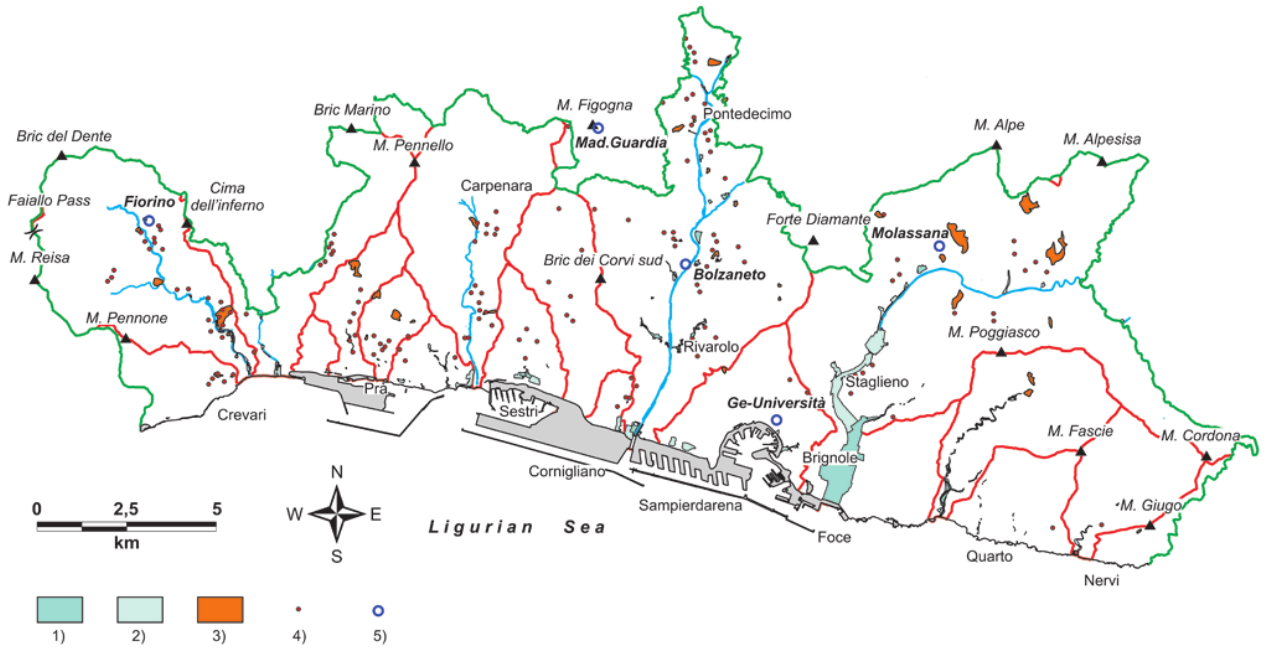
Fig. 8. The map shows: historical flooded areas with return time of 50yr (1) and 200yr (2); high risk landslides identified for Civil Protection purposes (3); shallow landslides based on data inventory 1991–2011 period (4); location of most weather stations in Genoa Municipalitiy cited in the text (5) (modified from Comune di Genova, 2008).